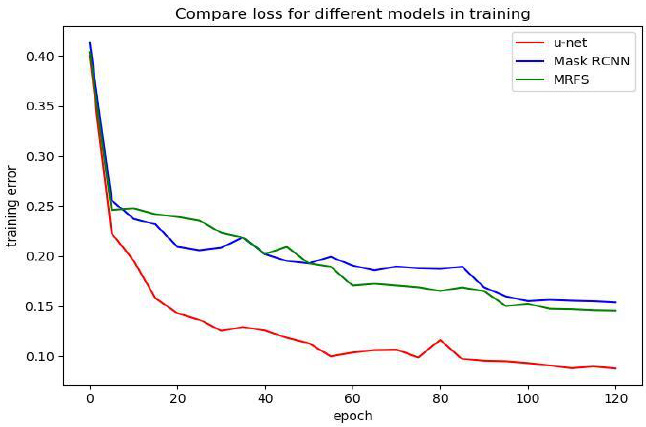
Figure 8. Comparison of u-net, mask R-CNN and MRFS on training error.